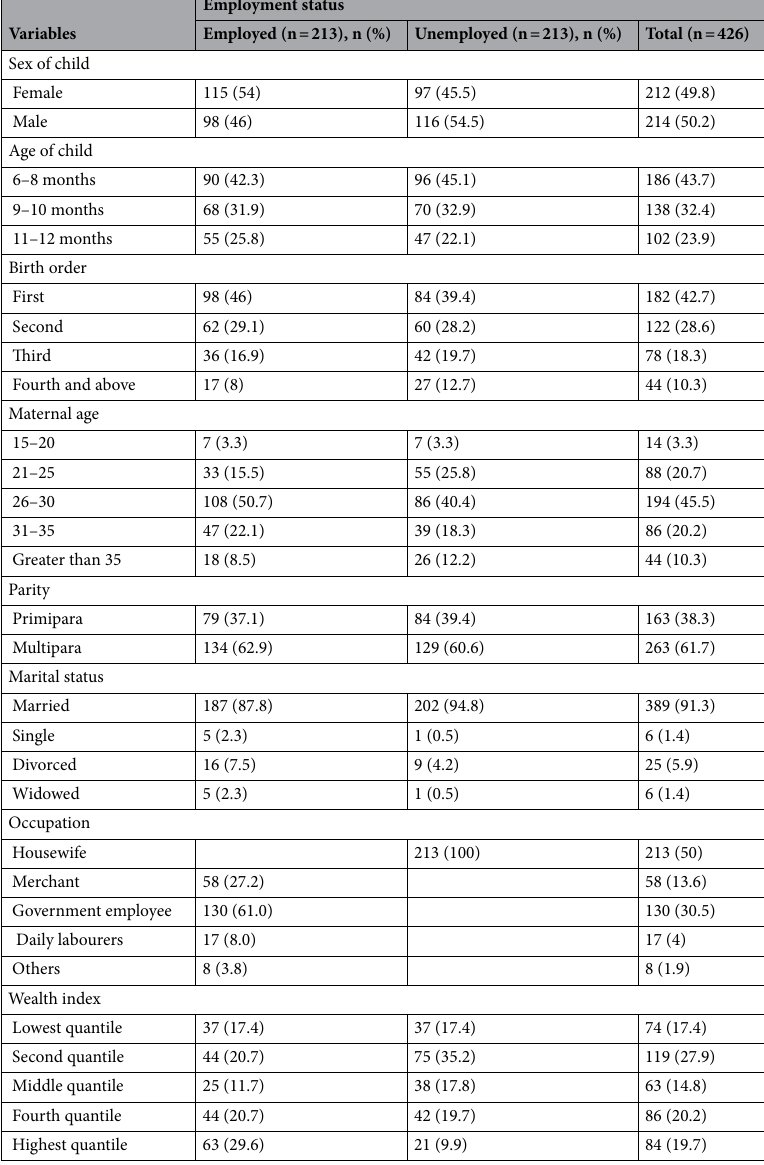
Table 1. Socio-demographic characteristics of the study subjects according to the employment status of mothers of 6–12 months old infants at Debre tabor town, Northwest Ethiopia,